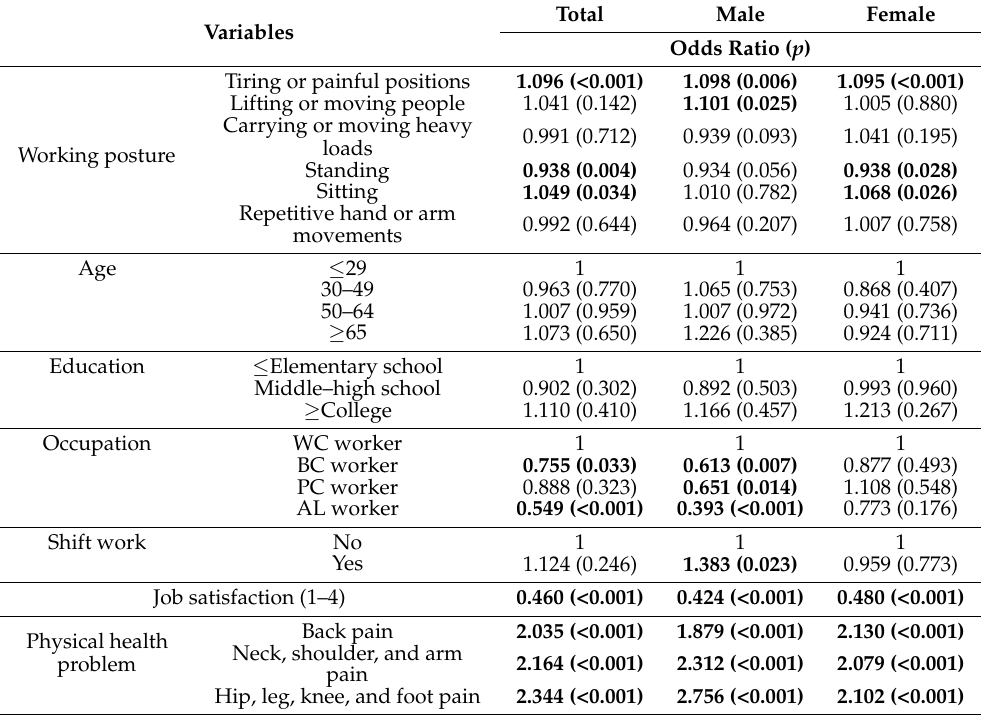
Table 2. Working posture affecting depression in